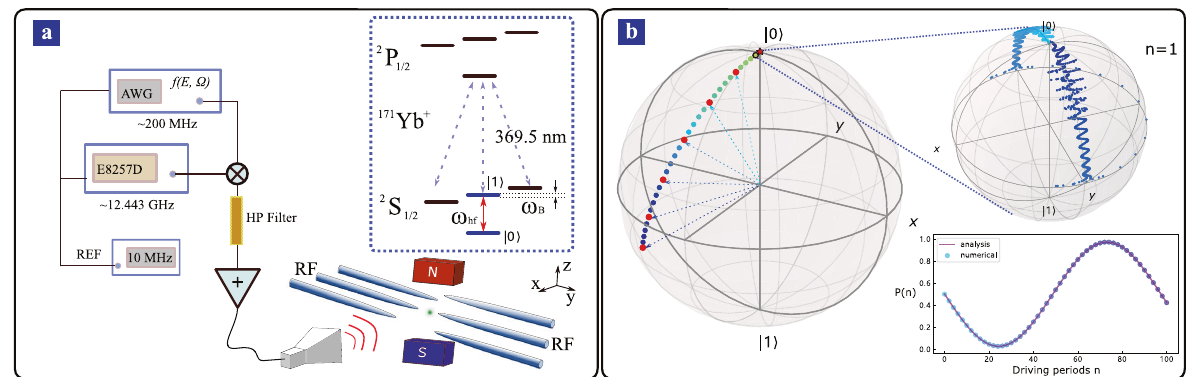
Fig. 1 Experimental procedure to measure Floquet dynamics in a trapped-ion system. a The qubit is encoded in the clock transition of a single trapped 171 Yb + ion. The qubit is periodically driven by a microwave fi eld generated by an AWG and a fi xed-frequency signal source, which are both referenced to a 10 MHz rubidium frequency standard. b On the right Bloch sphere, the qubit is initialized to 0 j i and evolves to U ð T Þ 0 j i after one period of driving with function f ( E = 16, Ω = 5). The fast dynamics ( “ micromotion ” ) of the qubit during this elementary period is shown on the Bloch sphere, and arises from the intrinsic time-dependence of the Floquet states Φ j ð t Þ starts from 0 j i (the north pole) and evolves to U ð nT Þ 0 j i for multiple periods n = 1, 2, 3, . . . , 30. The red dots are the points measured at n = 5, 10, 15, 20, 25, 30. The insert shows the probability P ( n ) of projecting the qubit onto y function of n , with frequency proportional to the quasienergy ϵ j ( E ). For values of E satisfying ϵ j ( E ) = 0, the state is frozen at 0 j i and P ( n ) = 1/2 for all n . Since ϵ j ( E ) is proportional to the real part of − ζ (1/2 + iE )/(1/2 + iE ), we can therefore identify Riemann zeros by observing the freezing of the dynamics, i.e., P =